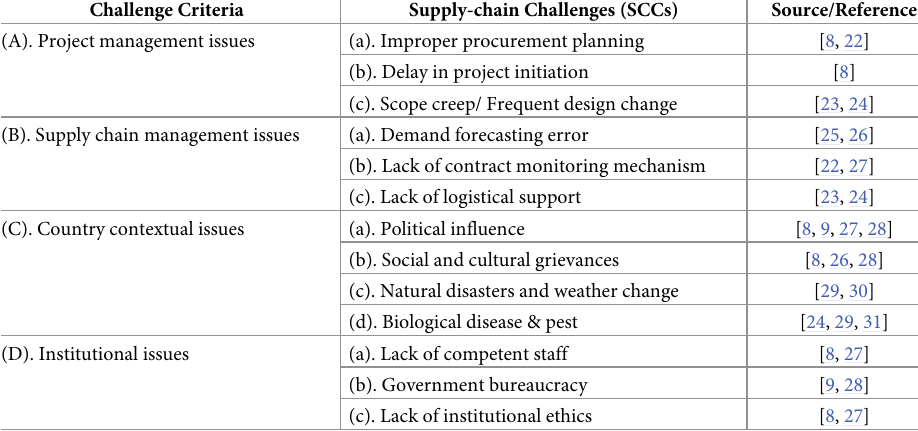
Table 1. The primary framework of the challenges to public sector agriculture project supply chain.